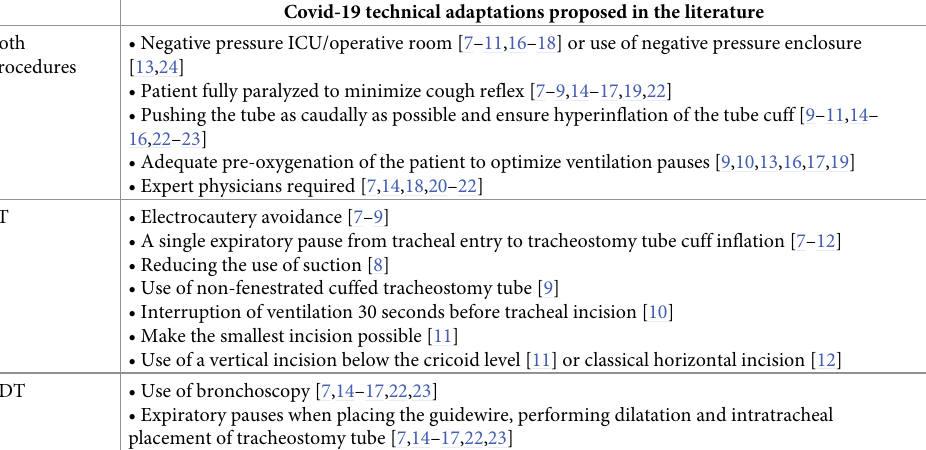
Table 1. Technical adaptation of surgical (ST) and percutaneous dilatational (PDT) tracheostomy procedures to minimize